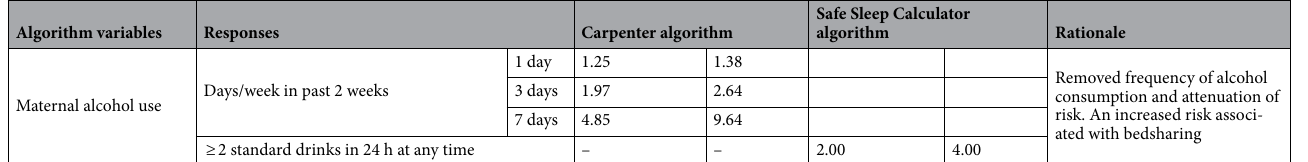
Table 1. Comparison of the Carpenter algorithm and the revised Safe Sleep Calculator algorithm. CDC = Centers of Disease Control and Prevention, OR = Odds Ratio (see supplementary information for the revised algorithm).